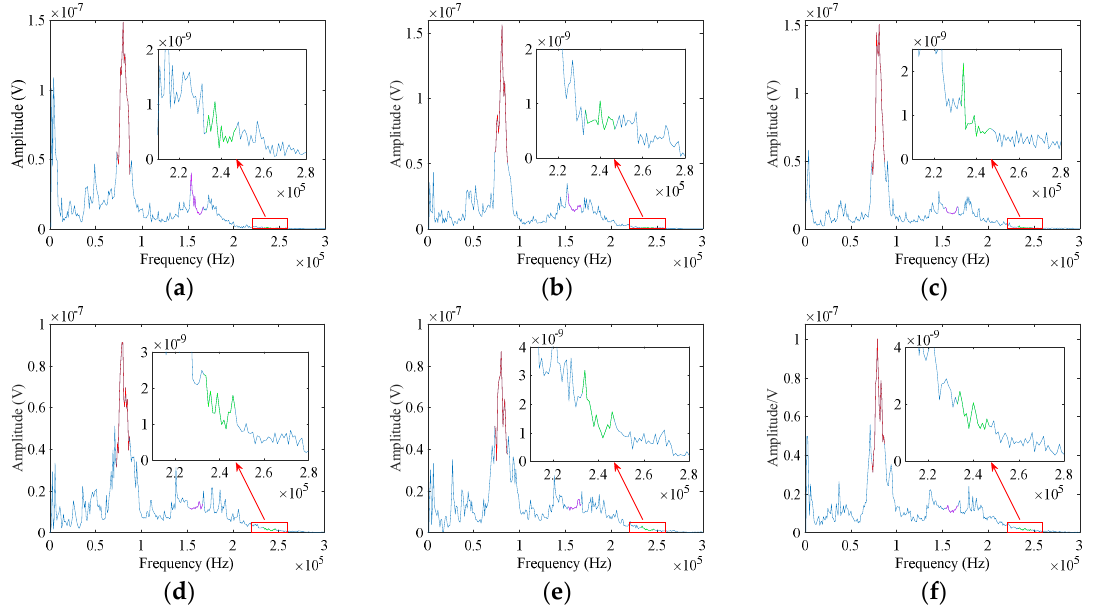
Figure 14. Marginal spectrum processed by HHT of different delamination damages. ( a ) 0 mm; ( b ) 4 mm; ( c ) 8 mm; ( d ) 12 mm; ( e ) 16 mm; ( f ) 20 mm. Table 1. Mean squared error of different processing processes.